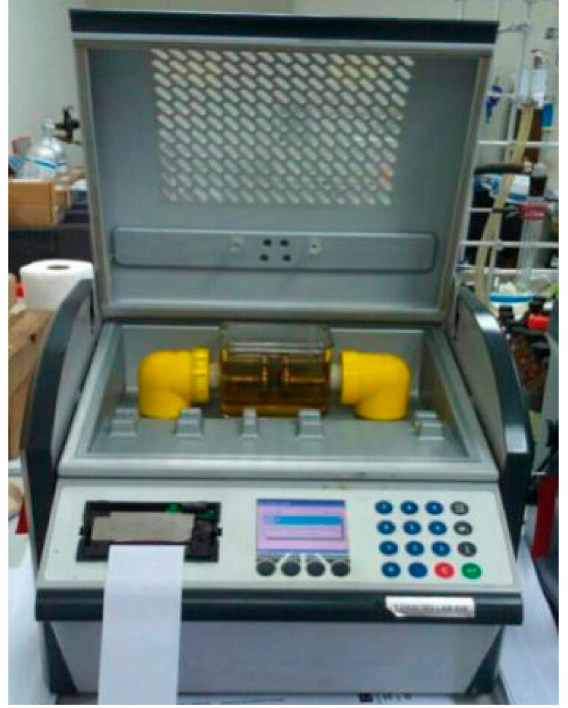
Figure 3. Oil test